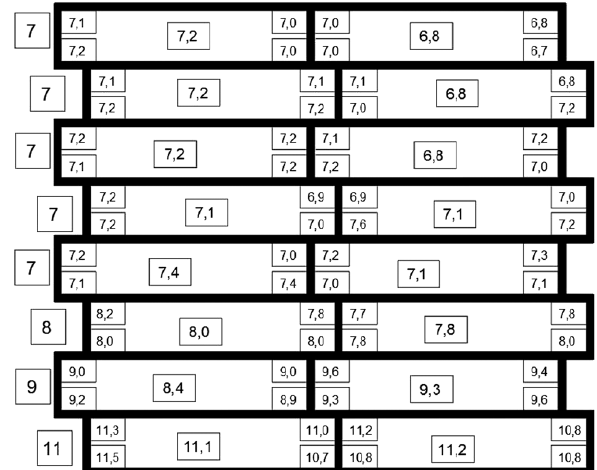
Figure 7: Location of measuring points presented in a selected segment of the tank shell. The reference of the results obtained from the measurements to the nominal thickness of each tested sheet is also shown here ( on the left side ) . These data are related to tank number 6 which is not considered in detail in this work.